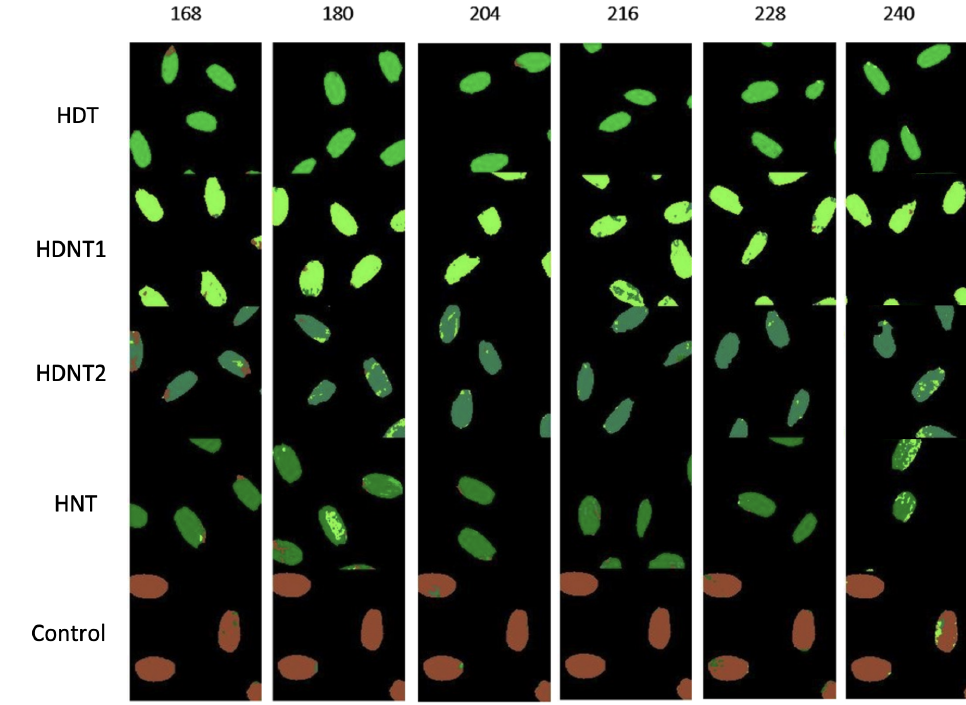
Figure 9. Classification map of HSIs of rice seeds from different hours of exposure for each tempera- ture treatment.